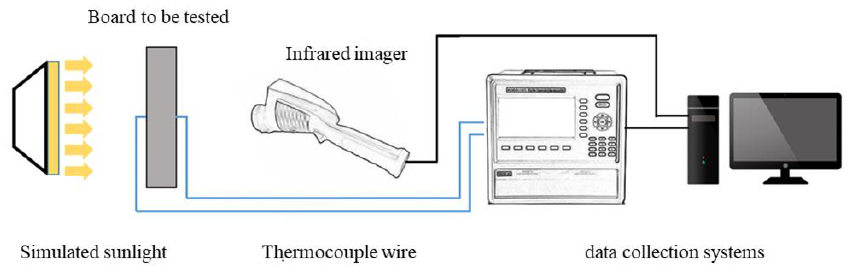
Figure 4. Test system for the single-side heating performance of concrete slabs.